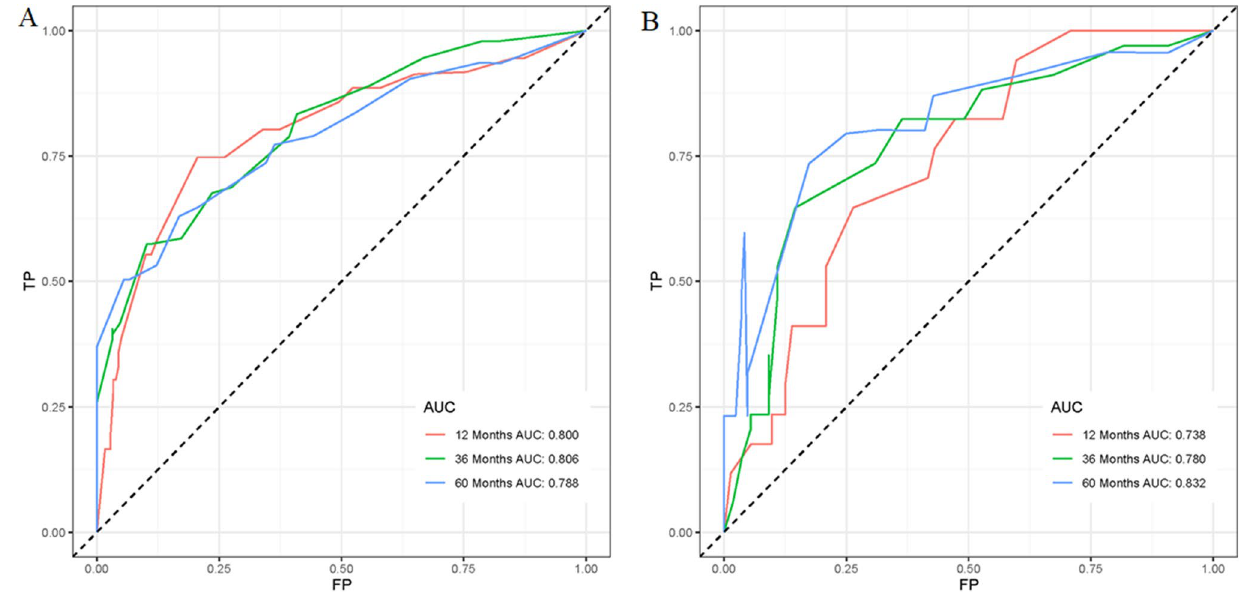
Figure 4. ROC curves for OS prediction of patients with retroperitoneal leiomyosarcomas. ROC curves of 1, 3, and 5 years in the training set ( A ), and ROC curves of 1, 3, and 5 years in the validation set ( B ) in this cohort retrospective study. Figure was generated by R software version 4.03 (http:// www.r- proje ct. org/).